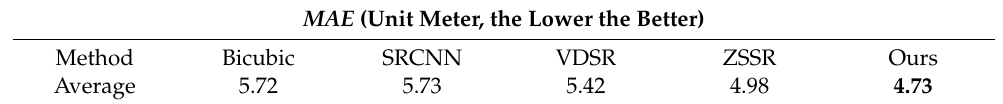
Table 3. MAE for the test regions.